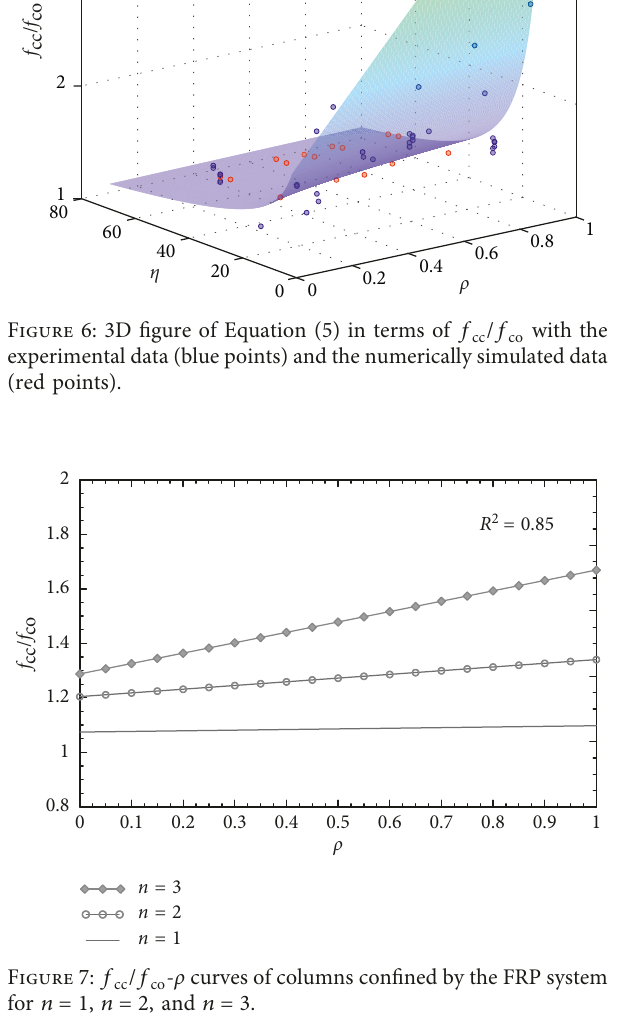
Figure 7: f / f - ρ curves of columns confined by the FRP system cc co for n � 1, n � 2, and n �